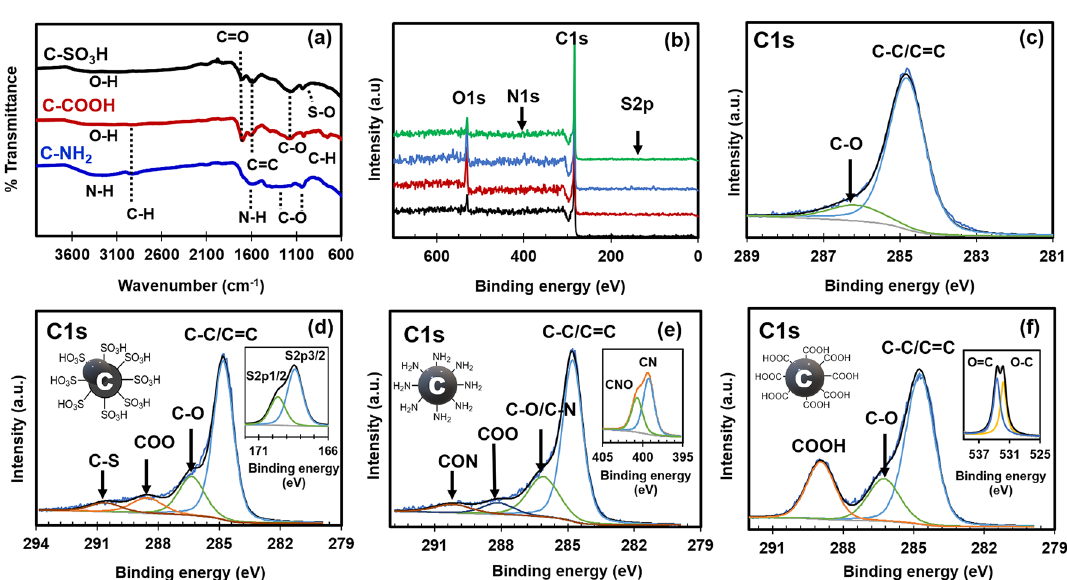
Figure 2. (a) FT-IR spectra of functionalised carbon. (b) XPS survey spectra and deconvolution of the core- level spectra of C1s of the (c) untreated carbon, (d) C-SO 3 H (with the inset of S2p), (e) C-NH 2 (with the inset of N1s), and (f) C1s of C-COOH (with the inset of O1s), respectively.